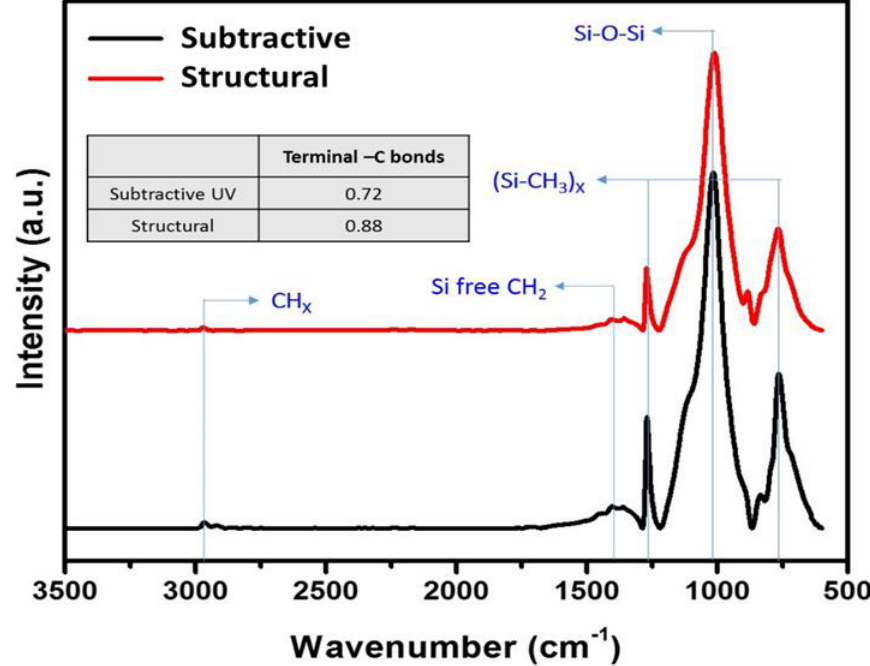
Figure 4. FTIR spectra between subtractive and structural PLK films.